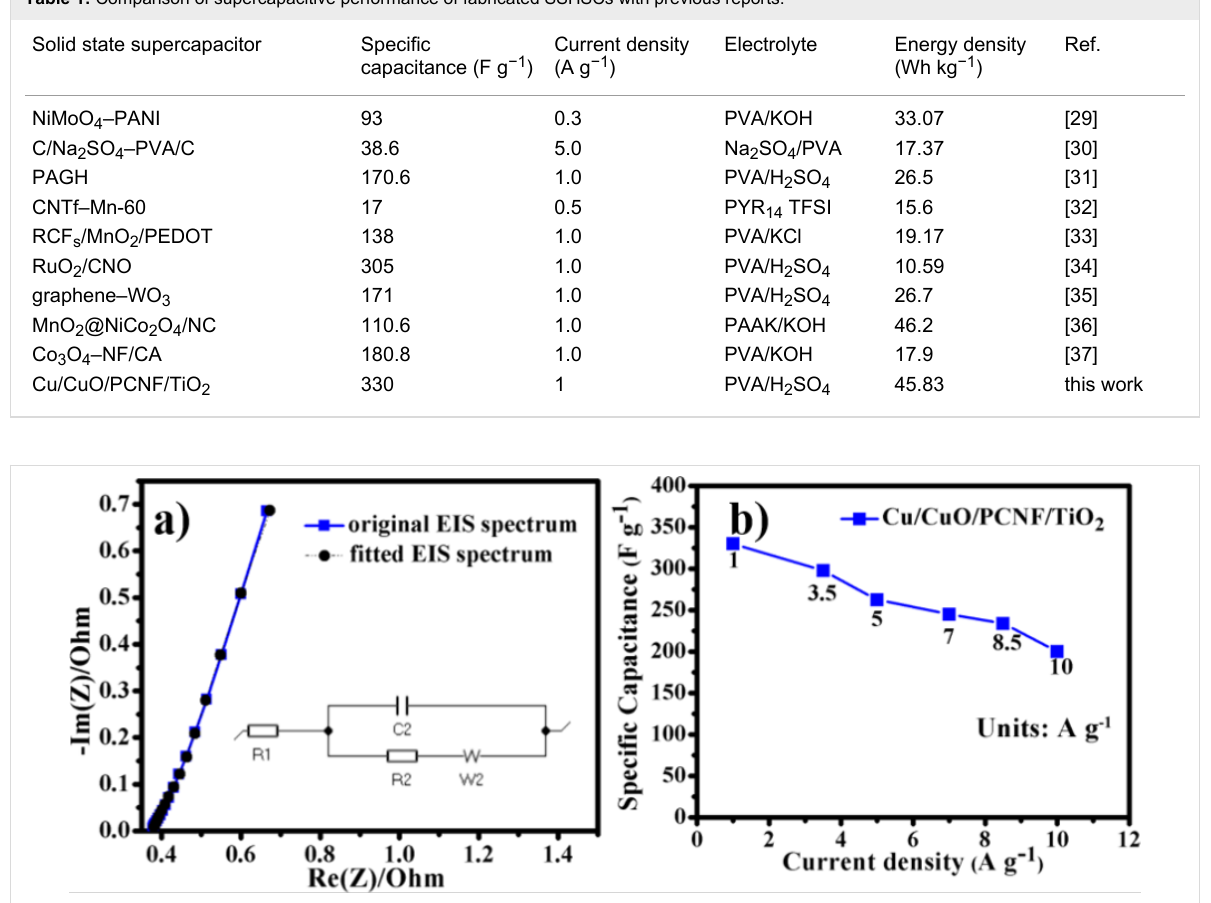
Figure 12: (a) Electrochemical impedance spectroscopy (EIS) spectrum of the SSHSC and (b) rate capability plot of the SSHSC at different current densities.